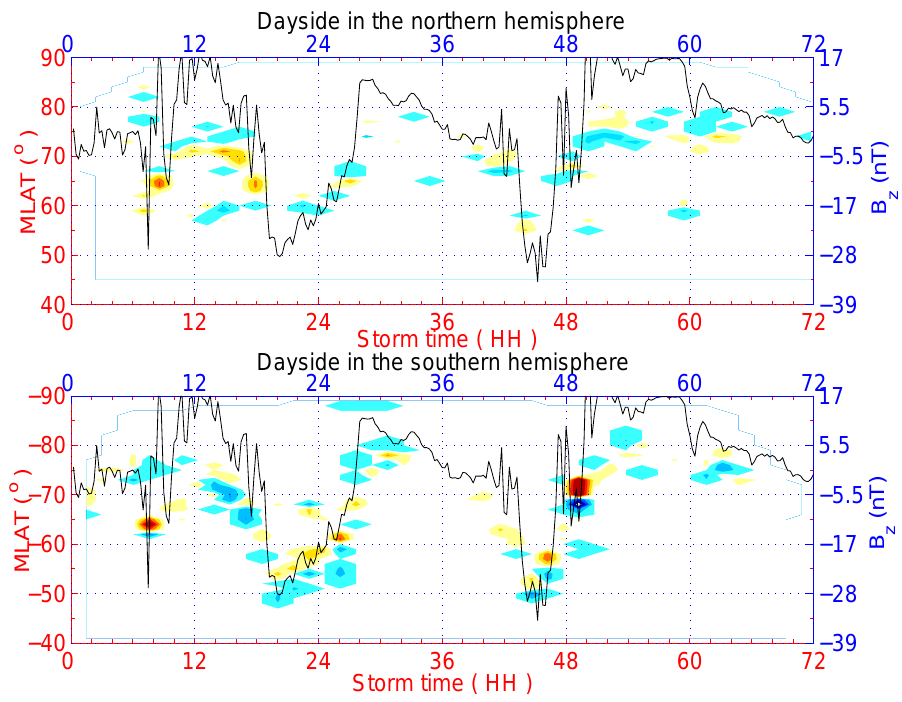
Fig. 4. Latitudinal variation of FACs occurrence on the dayside in comparison with the IMF B z amplitude in both hemispheres for the October